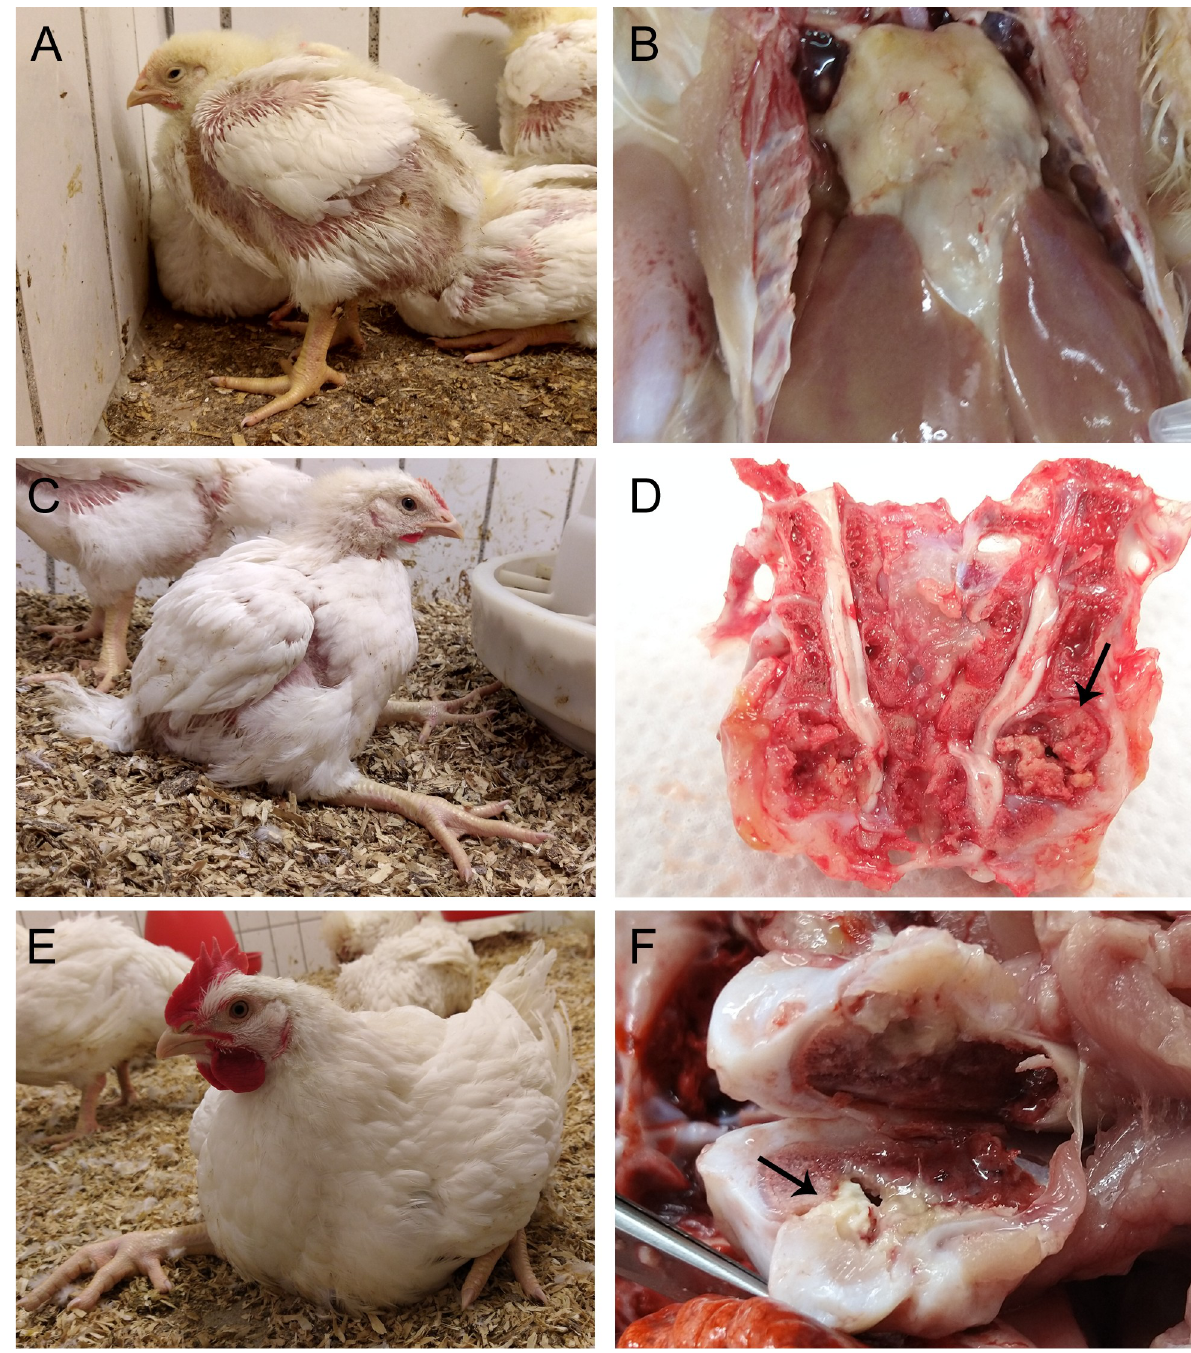
Fig 2. Clinical signs and pathology. (A) Clinical signs of the septic phase of the EC-infection (study day 15, EC14_low). (B) Pericarditis due to EC (study day 25, EC14_low). (C) Clinical signs of the skeletal phase of the EC-infection. This broiler was sitting on hocks and unable to walk (study day 29, EC14_low). (D) Spondylitis at the FTV (arrow). The vertebral column was removed and split sagittally to expose the lesion (study day 30, EC14_high). (E) Clinical signs of the skeletal phase of the EC-infection. This broiler was lame due to femoral head osteomyelitis (study day 52, EC14_high). (F) Femoral head osteomyelitis (arrow). The femoral head was exarticulated by using a sterile scalpel and split sagittally (study day 43, EC14_low). EC was isolated in pure culture from the lesions in pictures B, D, and F.